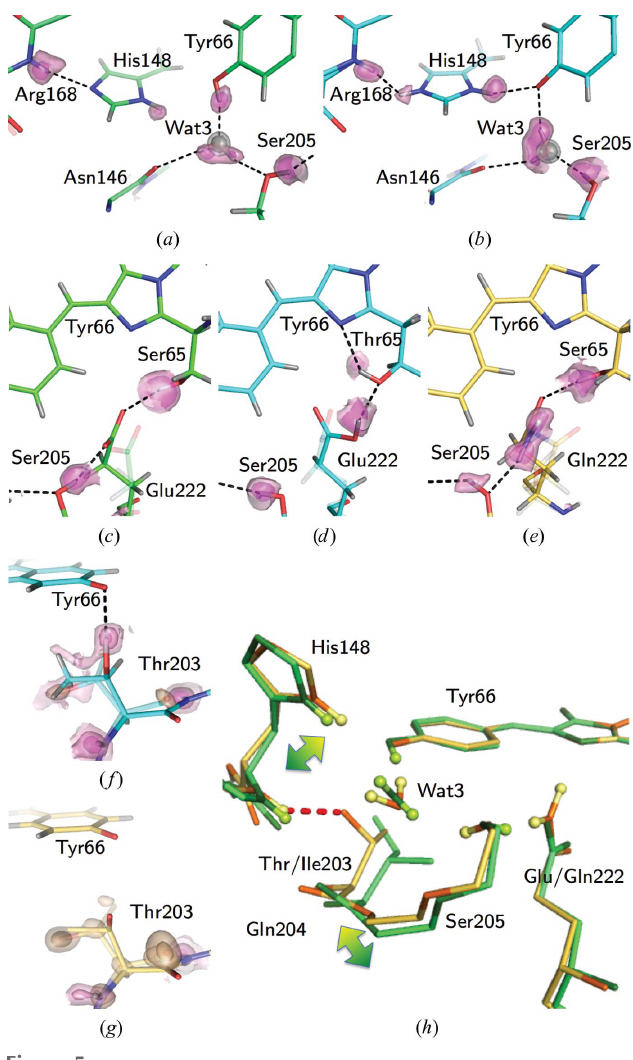
Figure 5 Differences in H-atom positions. ( a ) Electron density of H atoms around His148 and Tyr66 in T203I. ( b ) Electron density of H atoms around His148 and Tyr66 in S65T. ( c ) Electron density of H atoms around Glu222 and Ser65 in T203I. ( d ) Electron density of H atoms around Glu222 and Thr65 in S65T. ( e ) Electron density of H atoms around Gln222 and Ser65 in E222Q. The 2 F o (cid:5) F c map for Wat3 contoured at 4 (cid:5) and 6 (cid:5) and the F o (cid:5) F c OMIT map for H atoms contoured at 2 (cid:5) and 3 (cid:5) are shown in gray and pink, respectively. Hydrogen bonds are represented as broken lines. The distances between the donor and acceptor are listed in Supplemen- tary Table S4. The minor conformations are shown as transparent models. ( f ) Electron density of H atoms and a minor conformation of Thr203 in S65T. Its occupancy is 0.08. ( g ) Electron density of H atoms and a minor conformation of Thr203 in E222Q. Its occupancy is 0.19. The F o (cid:5) F c OMIT map for the minor conformations contoured at 4 (cid:5) and 7 (cid:5) is shown in beige. The F o (cid:5) F c OMIT map for H atoms contoured at 1 (cid:5) , 2 (cid:5) and 3 (cid:5) is shown in pink. ( h ) The structural difference between the A (T203I) and B (E222Q) forms. The gradient-colored arrows indicate the positional shift between the two forms. A hydrogen bond between Thr203 and His148 in the E222Q variant is shown as a red dotted line, with a donor– acceptor distance of 2.956 (9) A˚